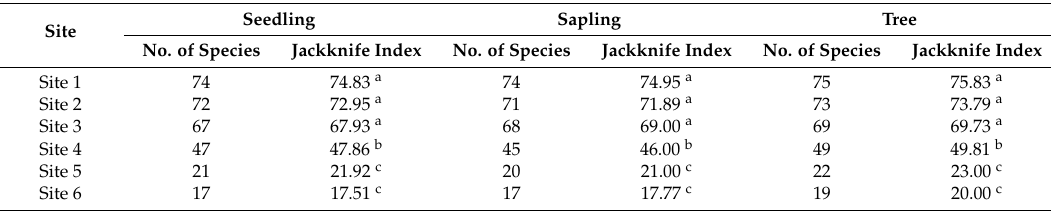
Table 4. Species richness of seedlings, saplings, and trees among six study sites.